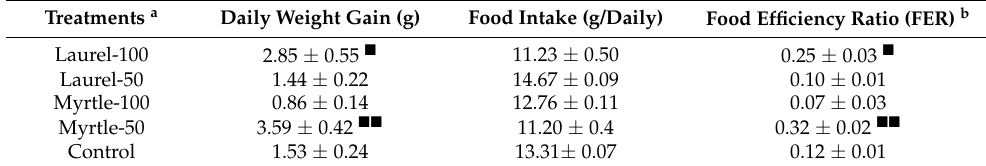
Table 2. Weight gain, food intake, food efficiency ratio (FER) in Laurel and Myrtle extract fed rats.